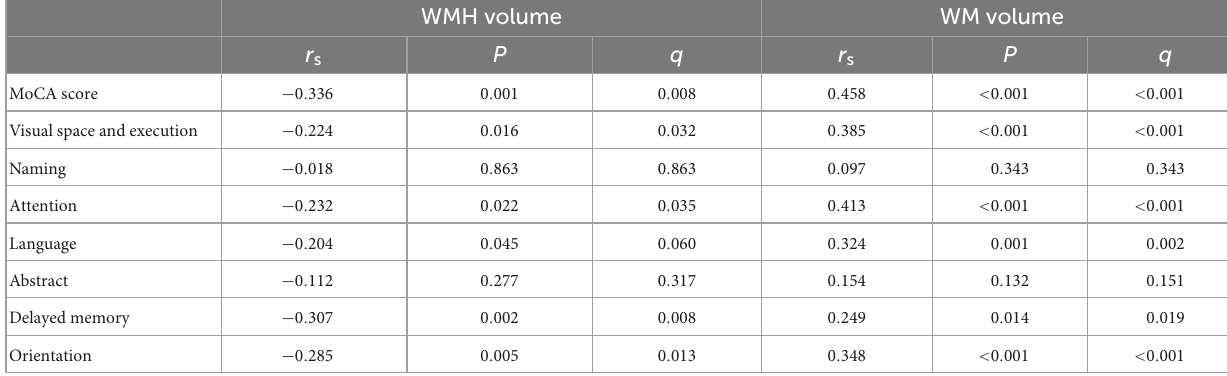
TABLE 5 Results of the partial correlation